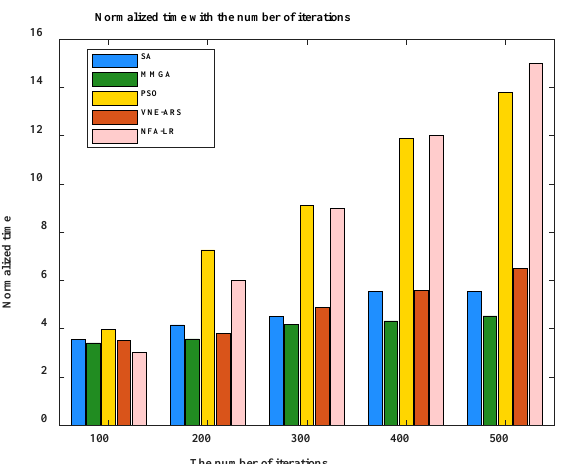
Figure 10. Normalization time consumed for different numbers of iterations.